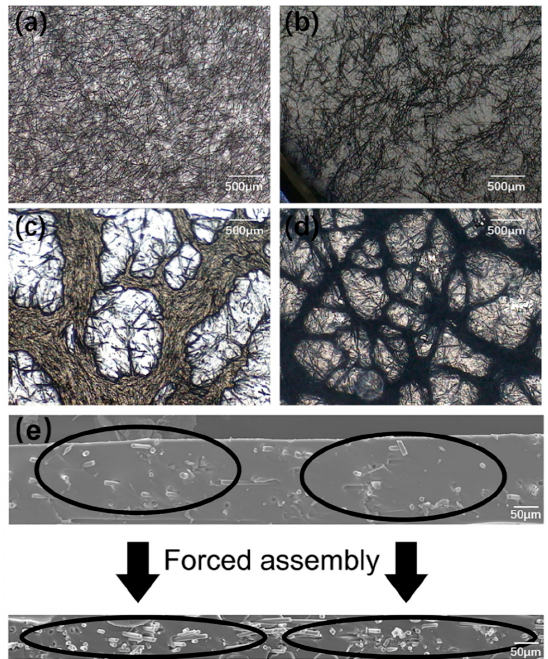
Figure 3. Morphology evolution of short carbon fiber network in PDMS: ( a ) homogeneous dispersion of short carbon fibers in PDMS after melt mixing; ( b ) a self-assembly network formed during conical twin-screw extrusion; ( c ) the free assembly network under compression; ( d ) forced assembly network under spatial confining compression; and ( e ) cross-section morphologies showing the evolution of the short carbon fiber network from self-assembly to forced assembly.